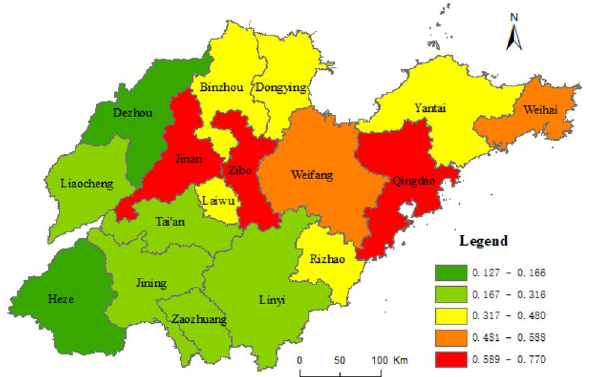
Figure 4. Urban–rural integrated level of Shandong province. This figure was created with ArcGIS 10.5 (URL:http:// www. esri. com/).